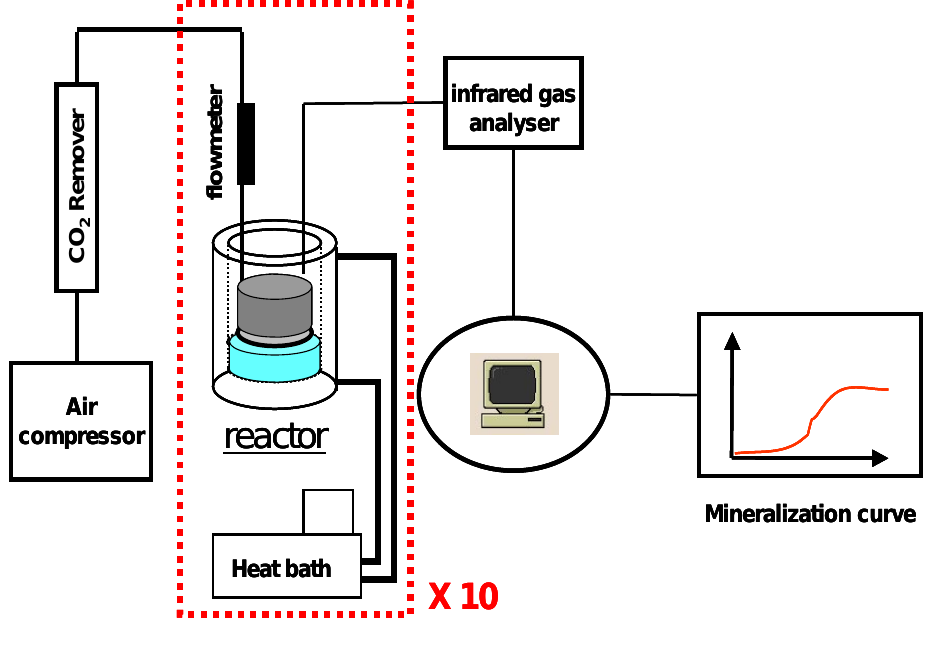
Figure 1. Schematic representation of the biodegradation test